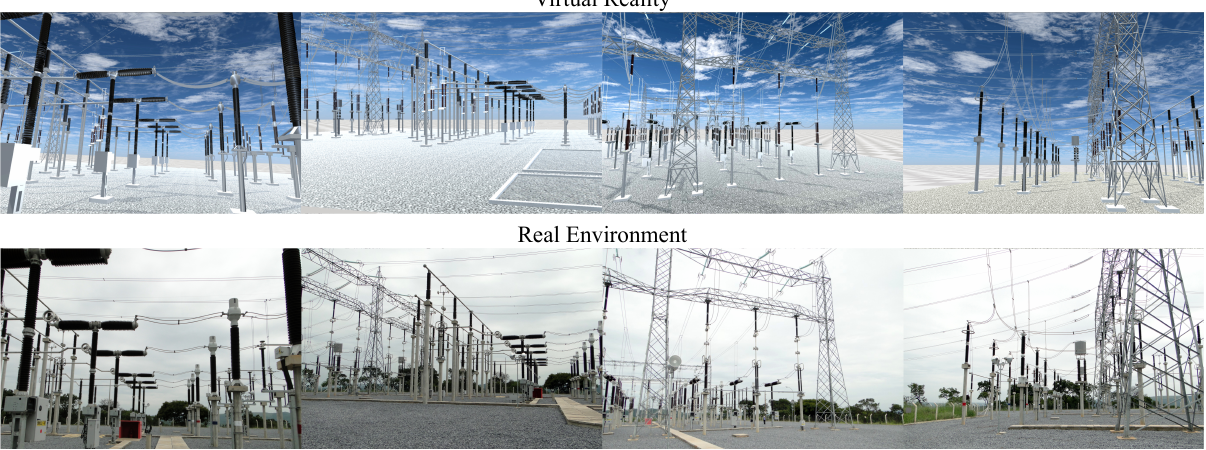
Figure 22. Images of the EPS in virtual reality and in the real